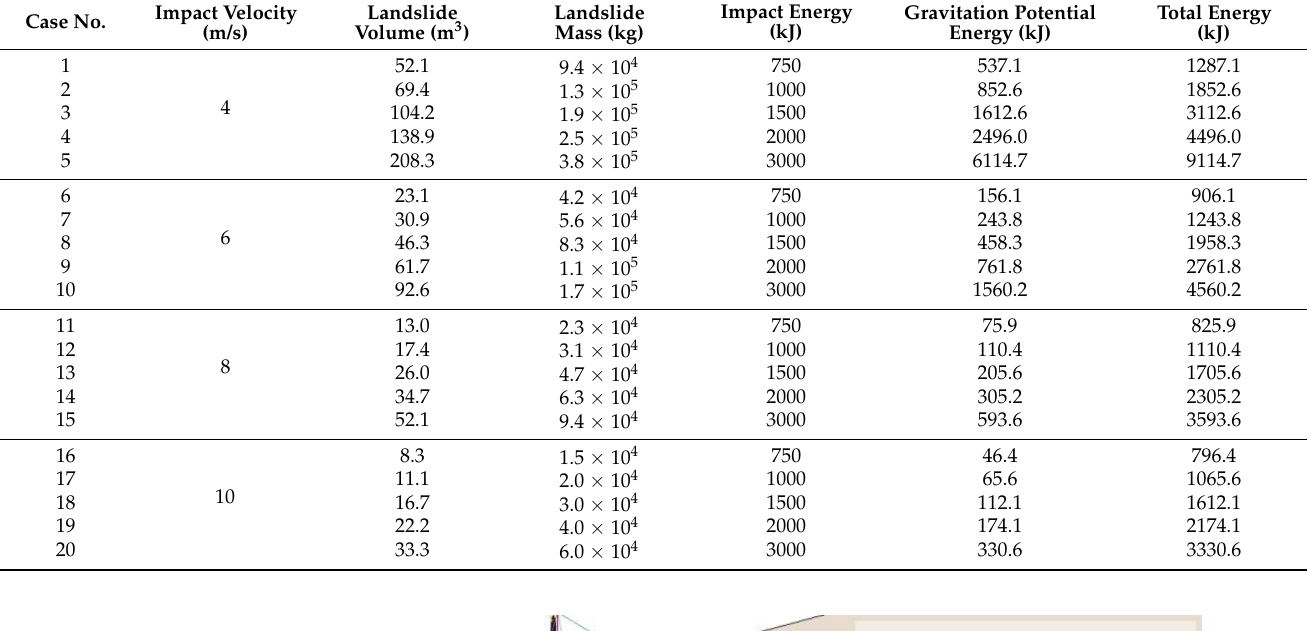
Table 4. Simulation schedule for a parametric study.